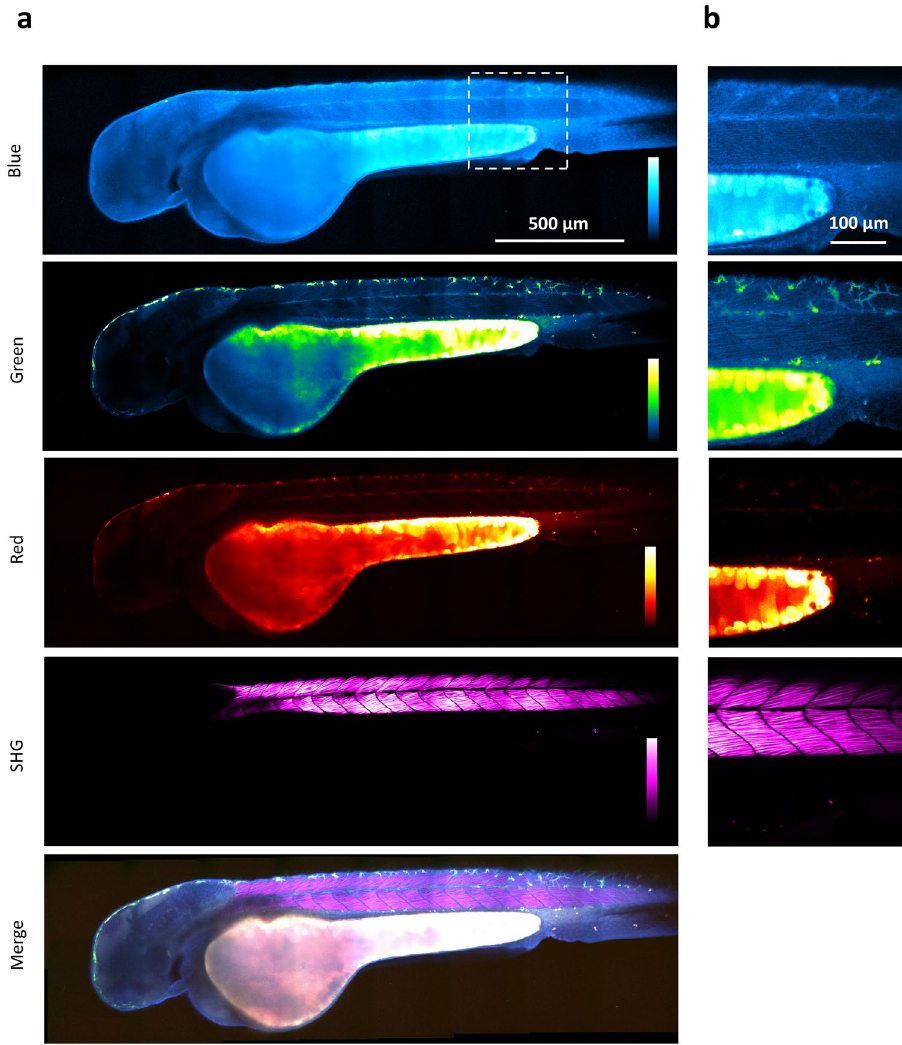
Figure 5. Multicolor two-photon efficient imaging of endogenous fluorophores in zebrafish embryo Images of the blue, green, red fluorescence, second harmonic generation, and merged channels of a live zebrafish